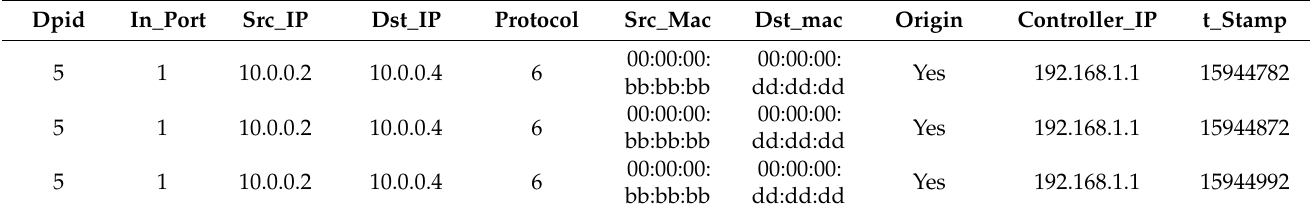
Table 3. IP traceback table for S5 in control domain 3.